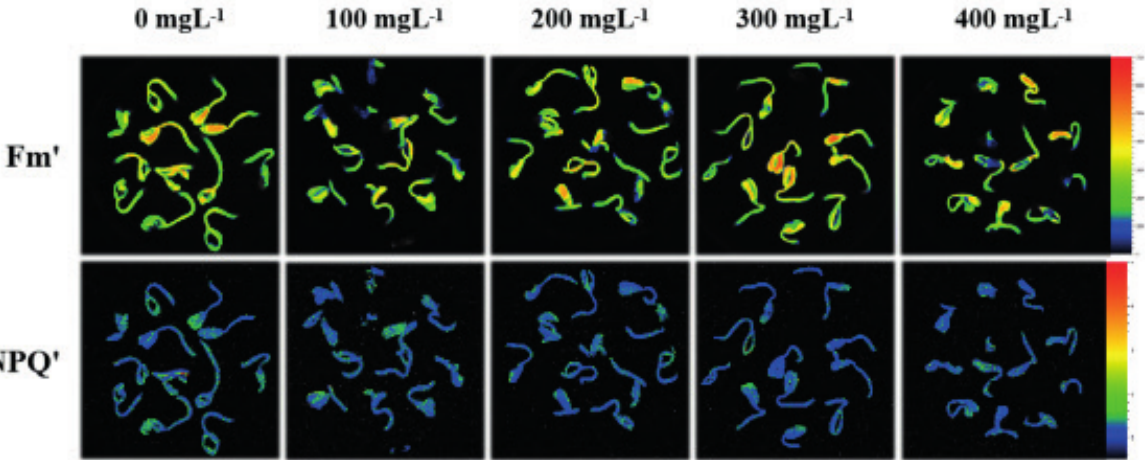
Figure 3. Fm’ and NPQ’ images, 120 h after soaking in 0, 100, 200, 300 and 400 mgL -1 of CuONPs, obtained by means of chlorophyll a fl uorescence